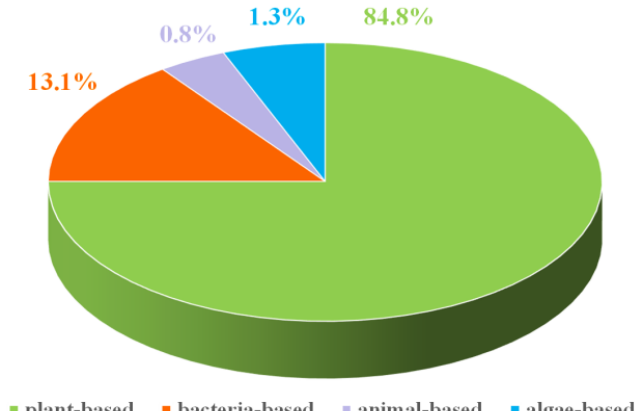
Figure 1. Biomass distribution image on biosphere.